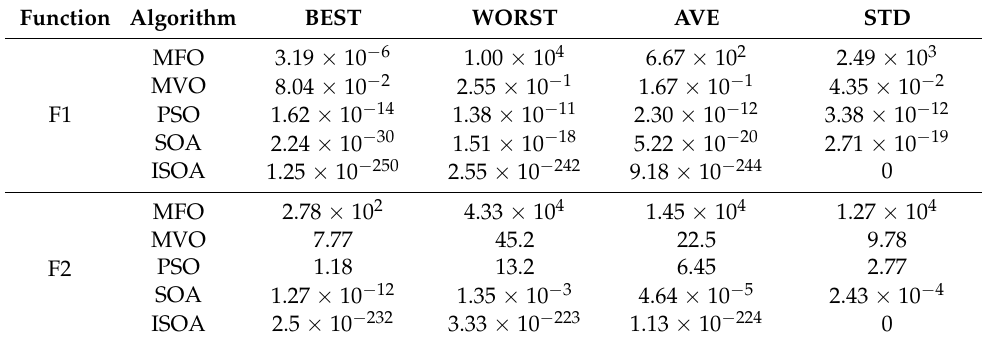
Table 2. Results of the classical unimodal functions. Function Algorithm